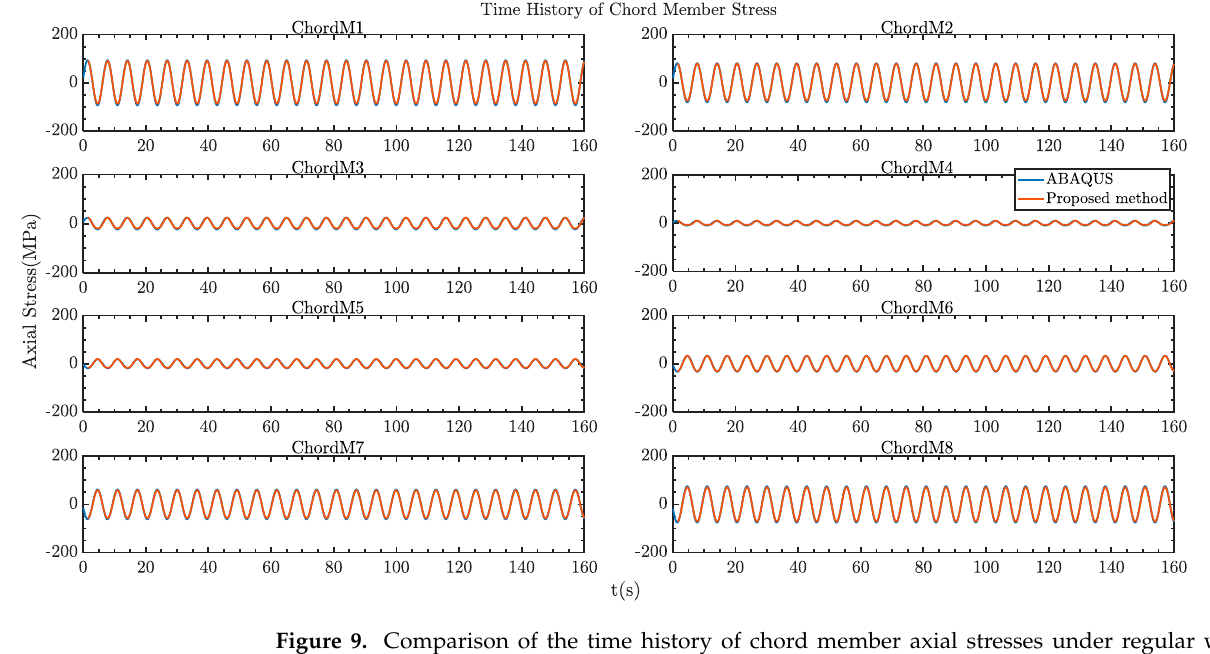
Figure 9. Comparison of the time history of chord member axial stresses under regular wave excitations.